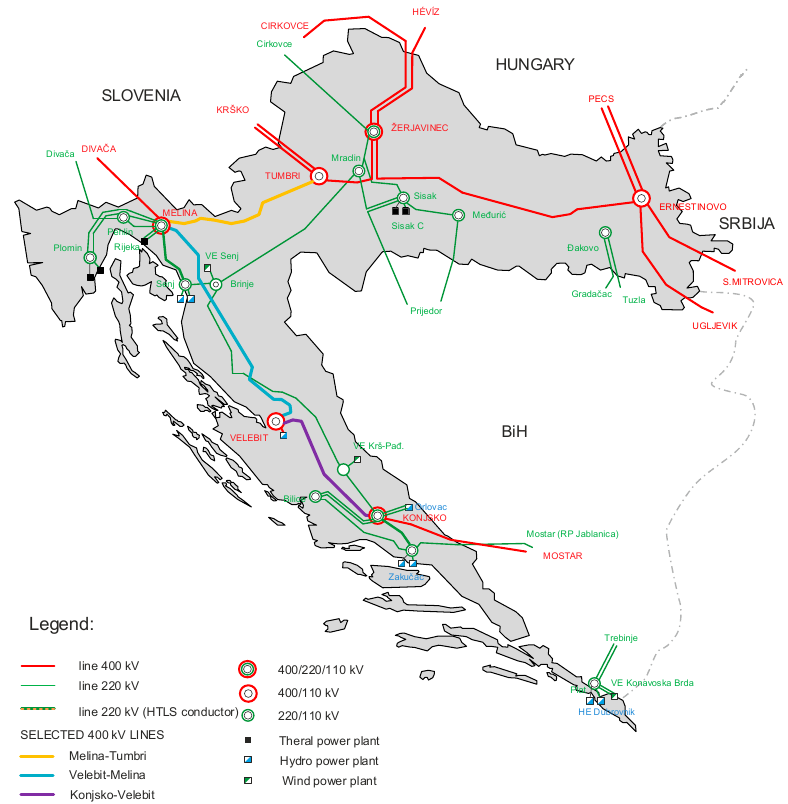
Figure 10. Croatian transmission grid .